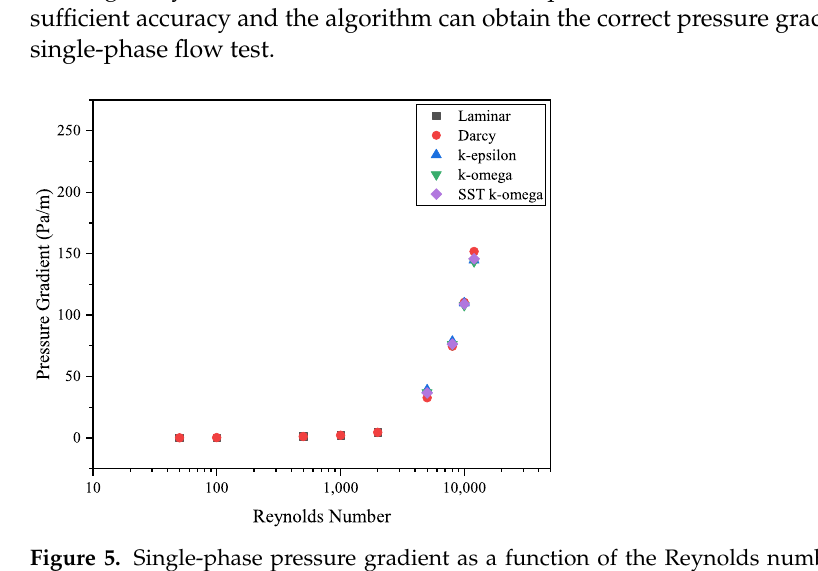
Figure 5. Single-phase pressure gradient as a function of the Reynolds number under different turbulence models and Darcy